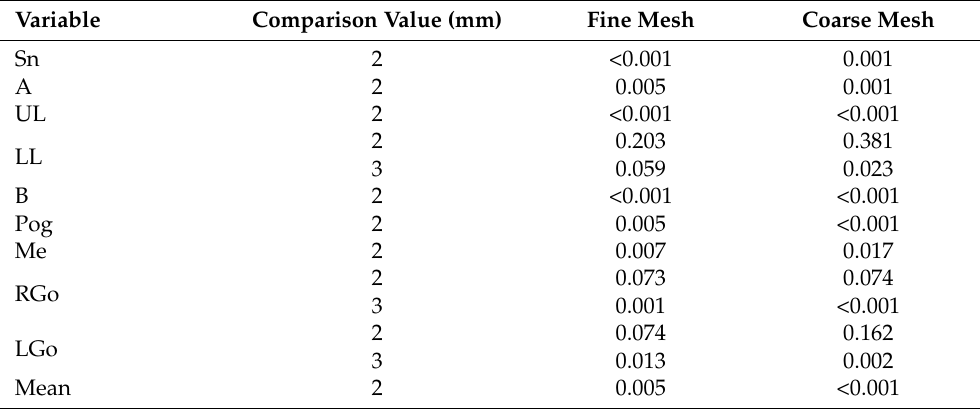
Table 3. p -values from the comparison of the distances of the anatomical landmarks and the mean distance for both meshes with 2 mm. For those that did not reach significance level (LL, RGo and LGo), comparison was also made with 3 mm.